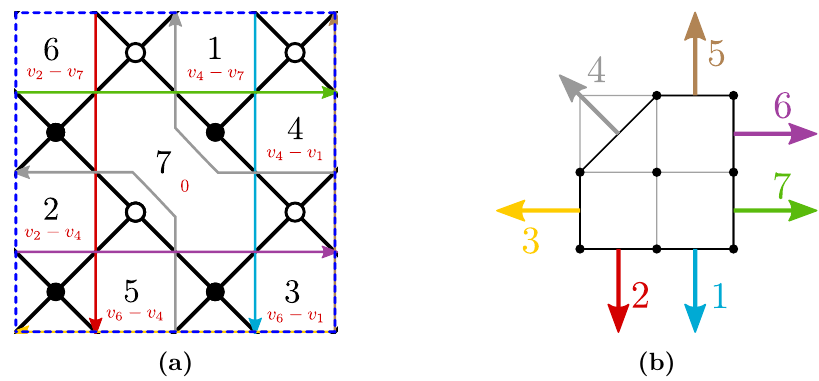
Figure 4. (a) Dimer diagram for PdP 4 . We show the ZZPs and the rank assignments coming from them. (b) The toric/web